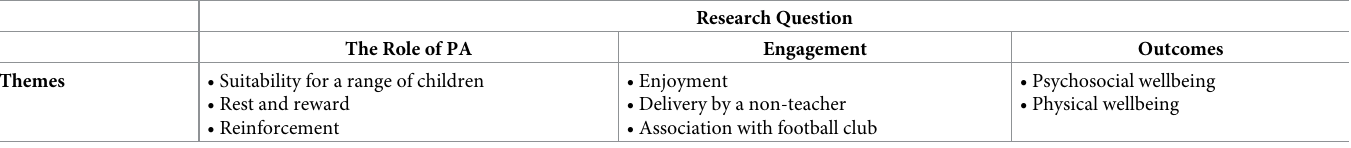
Table 1. Themes Identified for each of the research